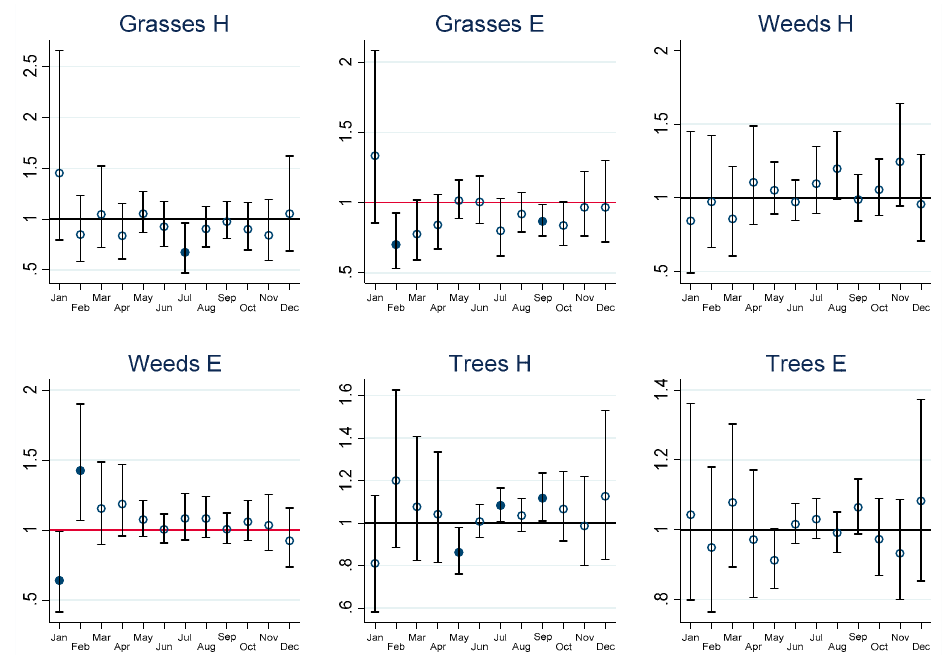
from day zero to day 7.